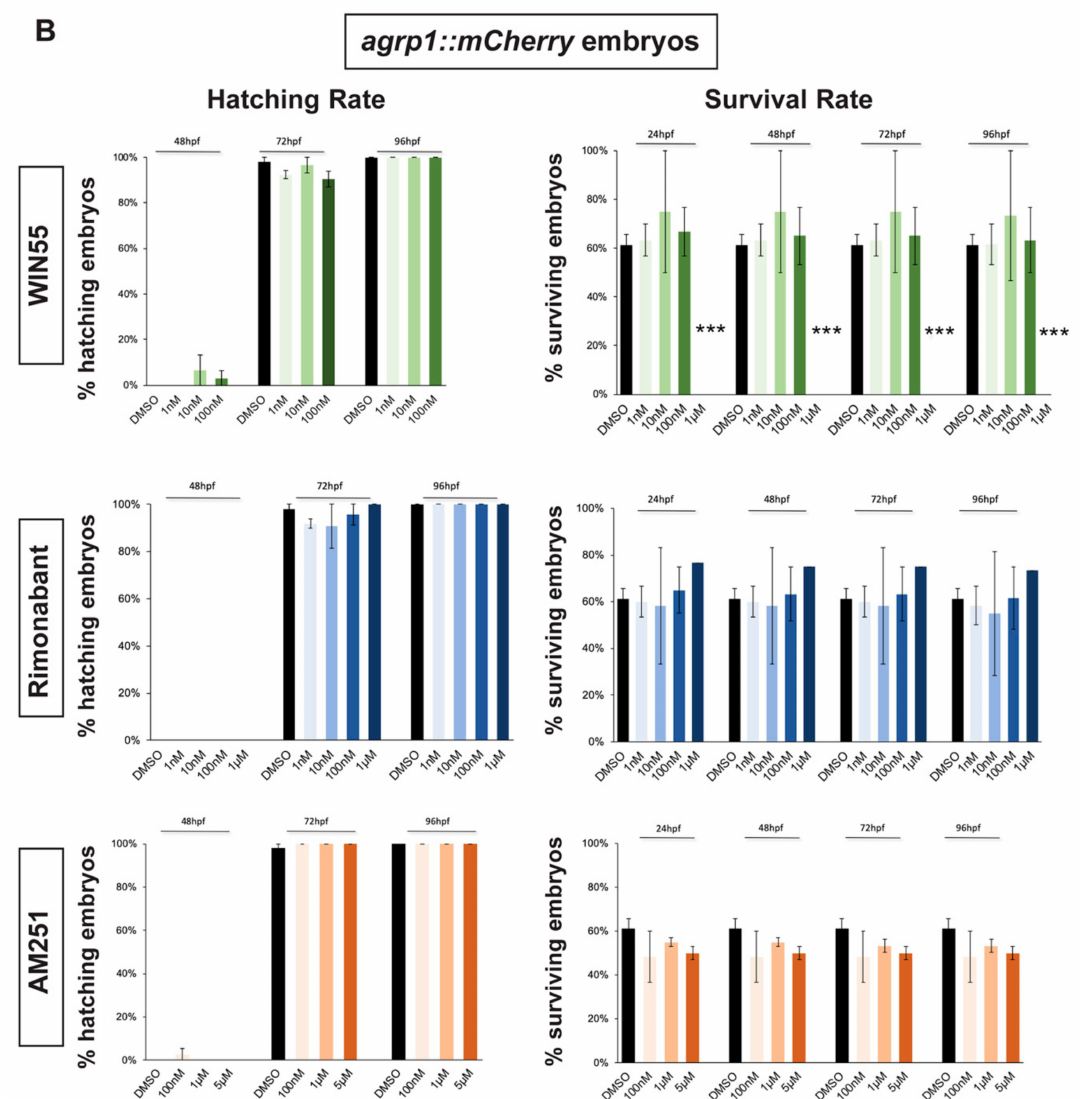
Figure 1. Survival and hatching rates in zebrafish embryos treated with CB1R ligands. ( A ) Hatching rate (panels on the left) and survival rate (panels on the right) of gnrh3::EGFP zebrafish embryos following treatments with WIN55, Rimonabant or AM251, at the indicated doses, examined at the indicated embryonic age. Results are expressed as % over the total number of embryos examined. ( B ) Same as in ( A ), but using agrp1::mCherry embryos. *** = p <